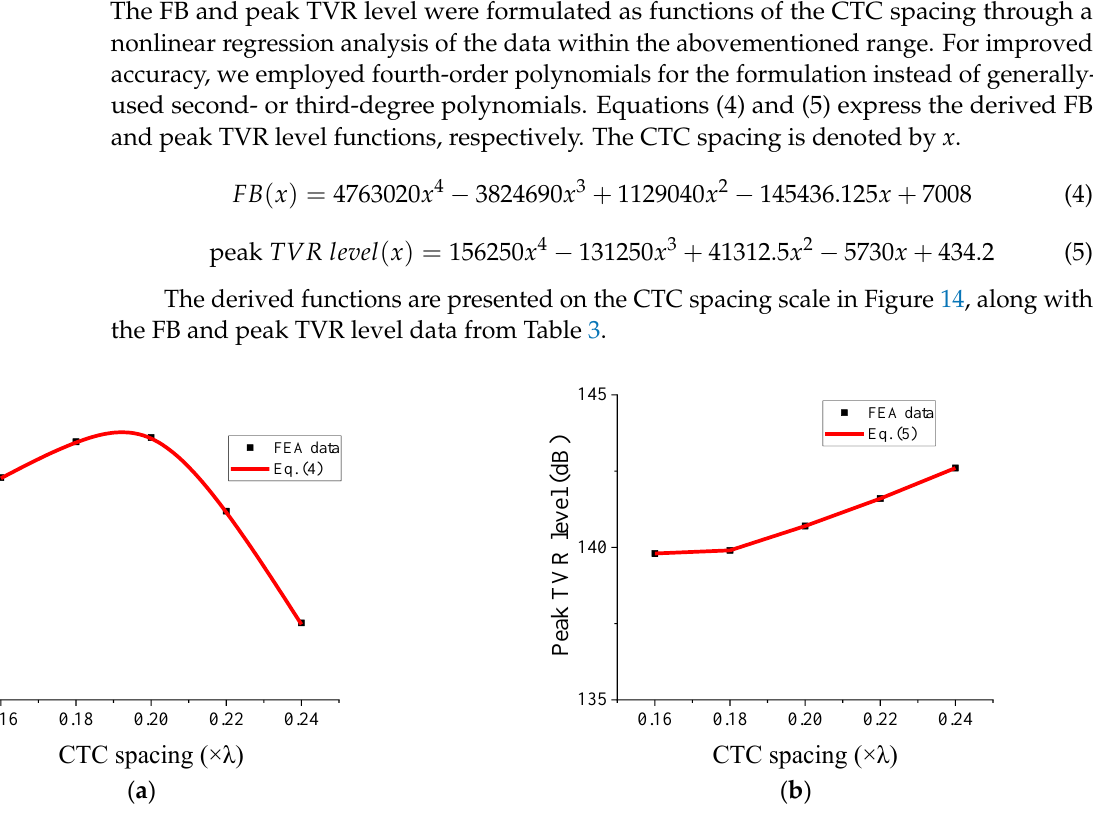
Figure 14. FEA data fitted with the fourth-order polynomial curve: ( a ) fractional bandwidth; ( b ) peak TVR level.